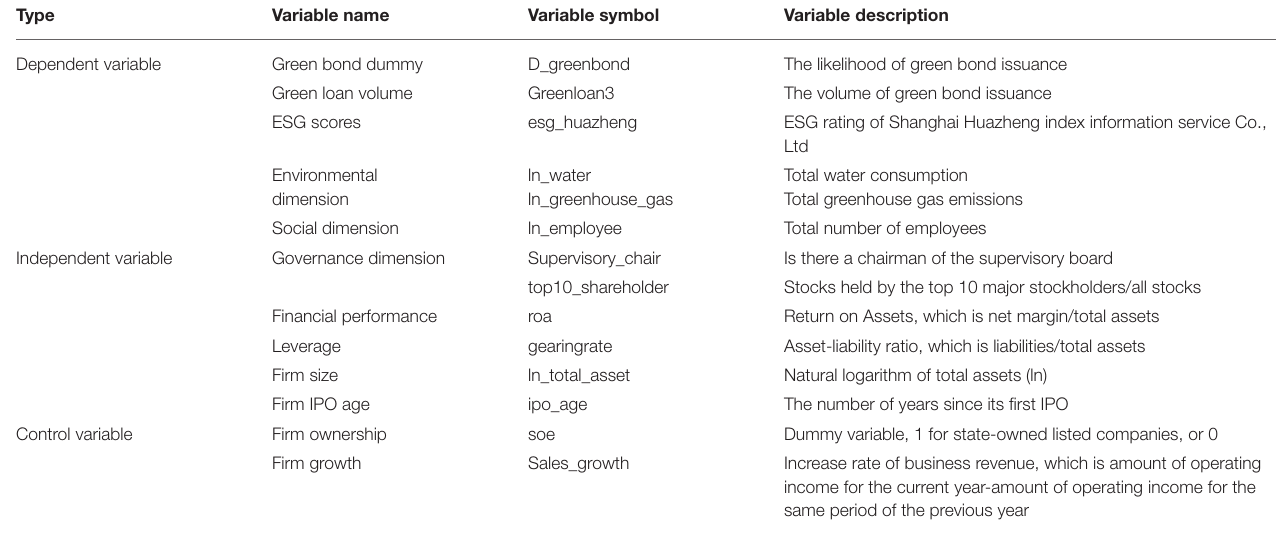
TABLE 1 | Variable